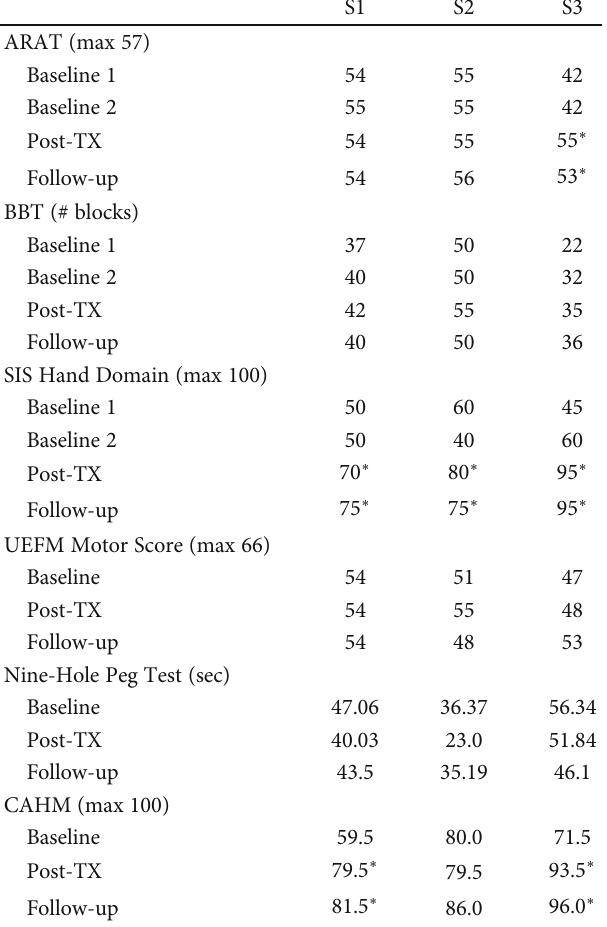
Table 3: Changes in clinical measures with